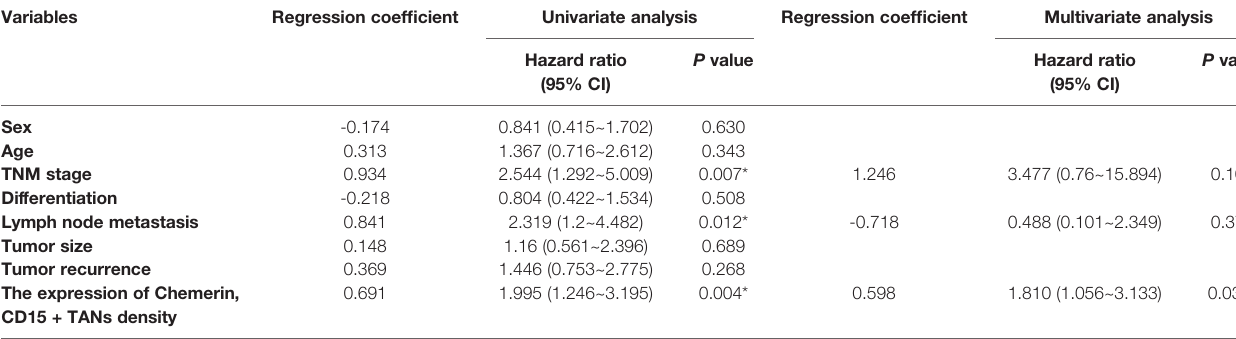
TABLE 3 | Univariate and multivariate overall survival analysis in OSCC patients. Variables